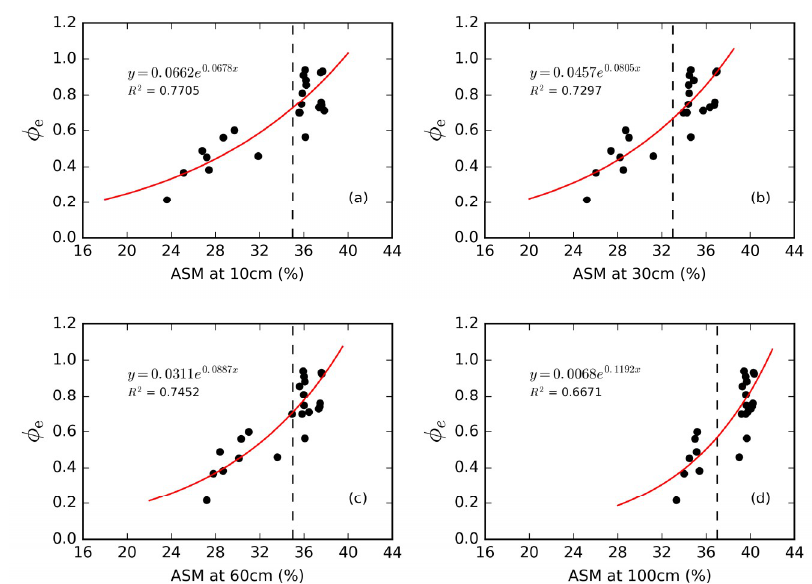
Figure 6. Relationship between φ e (Event‐based runoff coefficient) and ASM (Antecedent Soil Moisture) at different depths: ( a ) 10 cm; ( b ) 30 cm; ( c ) 60 cm; ( d ) 100 cm. The vertical line highlights the significant change.